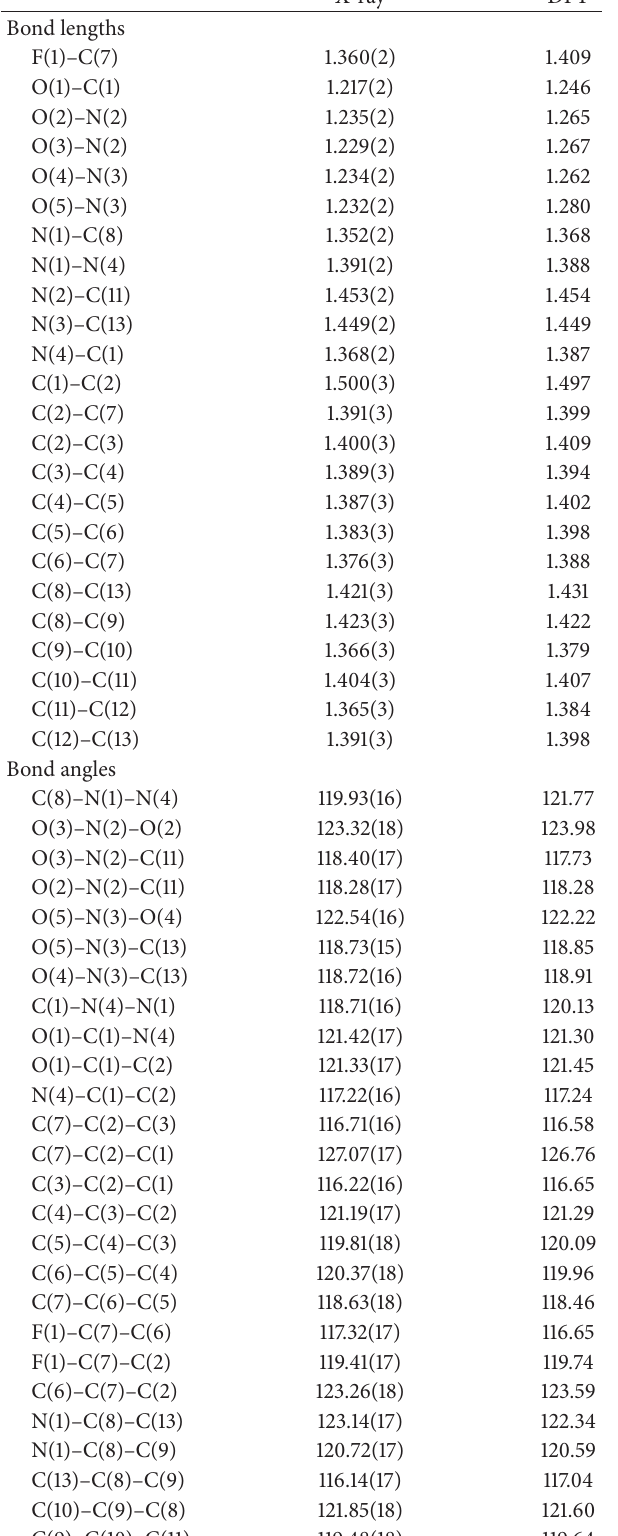
Table 2: The bond lengths (˚A) and bond angles [ ∘ ] for title com- pound ( 1 ) determined by X-ray diffraction and DFT calculations using 63-1G basis